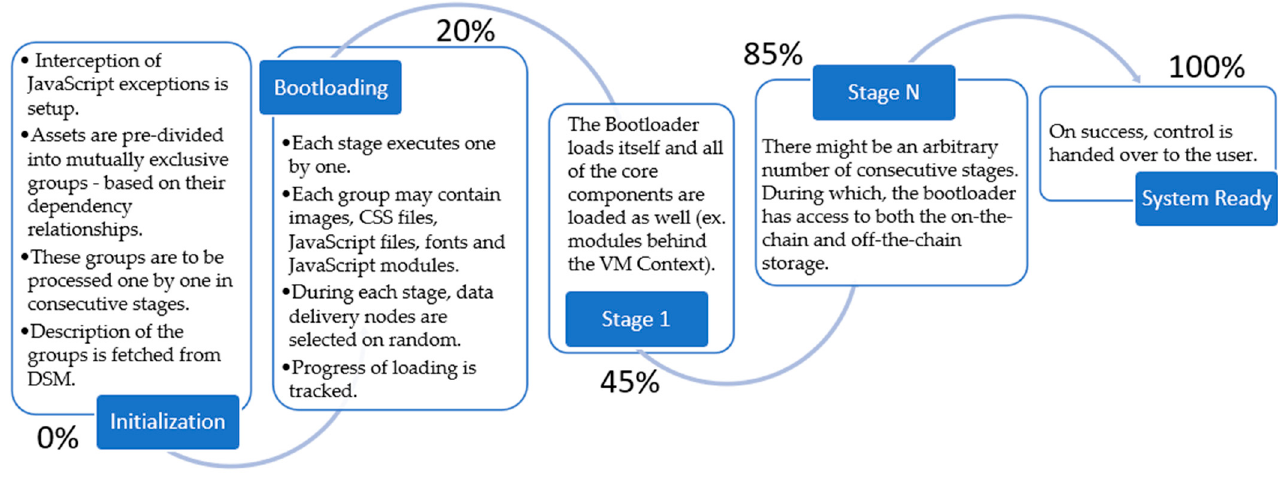
Figure 6. Assets are processed in separate stages.